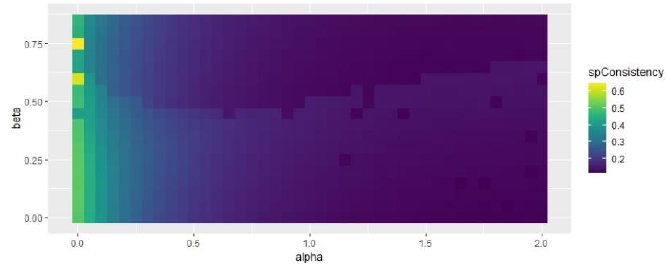
Figure 9. Influence of beta and alpha values on spatial inconsistency.